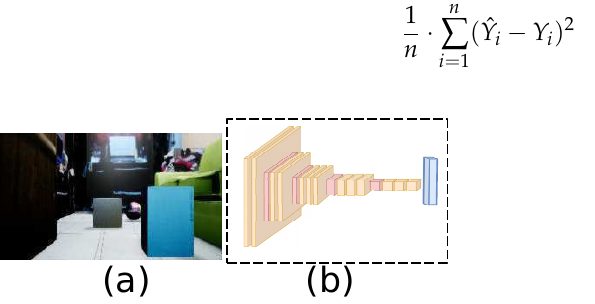
Figure 12. DCNN model to generate a path. ( a ) Input sample. ( b ) Feature extraction network.